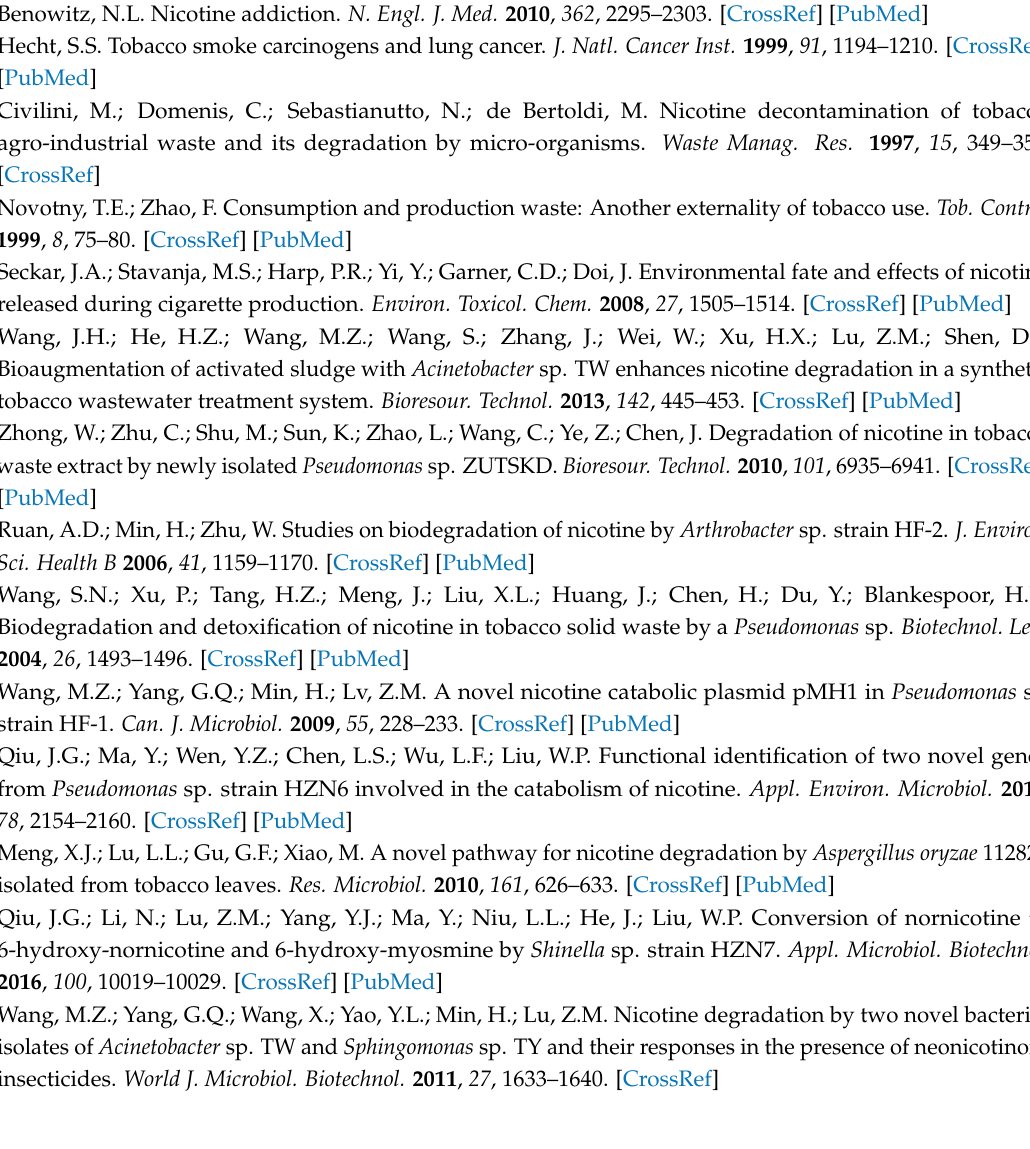
Figure S1: LC-MS profiles of the reaction catalyzed by HSPH ZZ . Mass spectra of products succinic acid ( m / z 117.15) (a), 2,5-DHP ( m / z 110.18) (b) and substrate HSP ( m / z 194.04) (c), respectively. Negatively charged ions were detected; Figure S2: Multiple sequence alignment for HSPH ZZ and its homologs. An alignment was carried out using Clustal W program with manual adjusting. The conserved GADGA motif is in shallow. Abbreviation: HSPH ZZ from Pseudomonas sp. ZZ-5; WP_013973865.1 from Pseudomonas putida S16; WP_031302470.1 from Pseudomonas sp. EGD-AK9; WP_064613869.1 from Pseudomonas sp. JY-Q; WP_035209888.1 from Agrobacterium tumefaciens S33; Figure S3: Thermal stability (A) and pH stability (B) of HSPHZZ. A. Thermal stability of HSPHZZ. The residual enzyme activity was measured after incubation of the purified enzyme at 30 ◦ C (triangles), 35 ◦ C (boxes), and 40 ◦ C (diamonds), respectively. B. pH stability of the enzyme at pHs ranging from 5.5 to 10 was measured for 30 min at 30 ◦ C. The values are means of three independent experiments. Table S1: Purification of the recombinant HSPH ZZ from Pseudomonas sp.